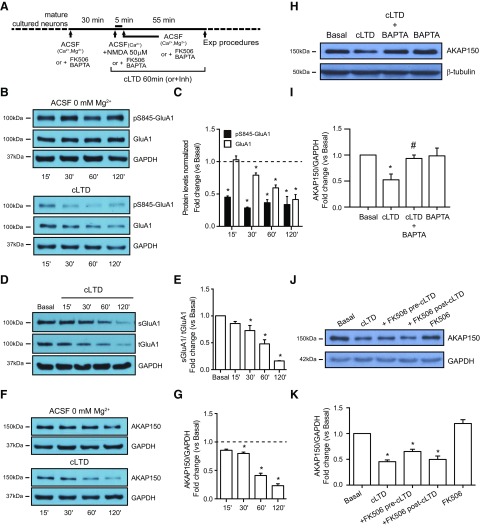
 cLTD reduces AKAP150. A, Cultured neurons were incubated in ACSF buffer for 30 min to equilibrate cells before 50 μM NMDA treatment for 5 min (cLTD). Cells were lysed after cLTD induction at indicated times (or 60 min if no time is indicated) in the presence or absence of inhibitors, antagonists, or cell-permeable Ca2+ chelators as indicated in the experimental design scheme. B, Representative blot images showing reduced levels of Ser-845 GluA1 and GluA1 after treatment (cLTD) compared with cells in ACSF buffer. Ser-845 GluA1 levels (pS845-GluA1; ∼110-kDa band, top panel) were related to total GluA1 (GluA1; ∼110-kDa band, middle panel). GAPDH was used as a loading control (∼36-kDa band, bottom panel). C, Quantification of pS845-GluA1 and GluA1 changes in response to NMDA stimulation compared with basal condition (n = 5–17, *p < 0.0001 vs basal). D, Representative blot images showing reduced levels of surface GluA1 after treatment (sGluA1; ∼110-kDa band, top panel) related to total GluA1 (tGluA1; ∼110-kDa band, middle panel). GAPDH was used as a loading control (∼36-kDa band, bottom panel). E, Quantification of surface GluA1 changes in response to cLTD compared with basal condition (n = 6, *p = 0.0310 for 30 min and *p < 0.0001 for 60 min and 120 min vs basal). F, Representative blot images showing reduced levels of AKAP150 after cLTD (∼150-kDa band, top panel) related to GAPDH (bottom panel). G, Quantification of AKAP150 changes in response to cLTD compared with baseline (n = 5–20, *p = 0.0021 for 30 min and *p < 0.0001 for 60 min and 120 min vs basal). H, J, Representative blot images showing the effect of the presence of Ca2+ chelator BAPTA (H; 20 μM) or Ca2+-dependent phosphatase CaN inhibitor FK506 (J; 10 μM) on AKAP150 protein levels after cLTD (top panel) related to β-tubulin (∼51-kDa band, bottom panel) or GAPDH (bottom panel) used as a loading control. I, K, Quantification of AKAP150 changes in response to cLTD in presence of BAPTA (I) or FK506 (K) compared with cLTD treatment (n = 3 in BAPTA experiments, *p = 0.0187 vs basal and #p = 0.0377 vs cLTD, n = 3–10 in FK506 pre-cLTD, *p < 0.0001 vs basal and FK506 post-cLTD experiments, *p = 0.0073 vs basal). Bar represent mean ± SEM.